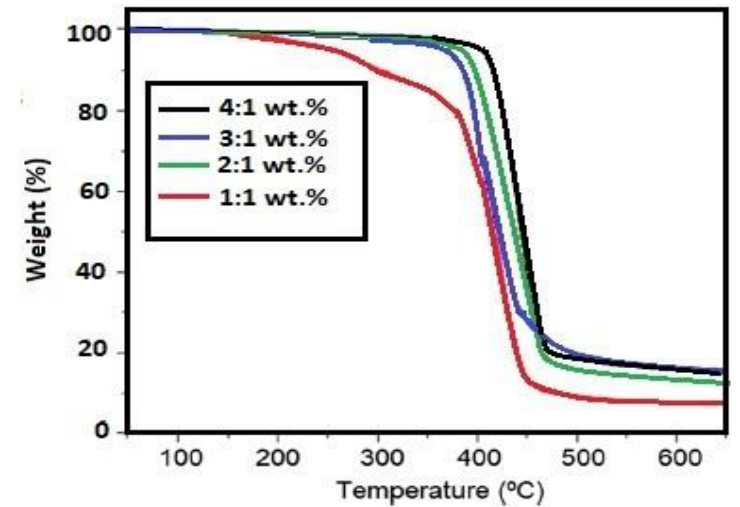
Figure 8. TGA thermograms of DGEB/PAIIL systems. Coatings 2020 , 10 , x FOR PEER REVIEW